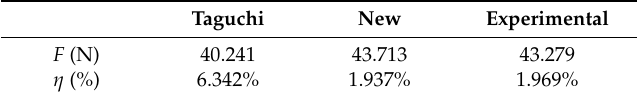
Table 12. Comparison of